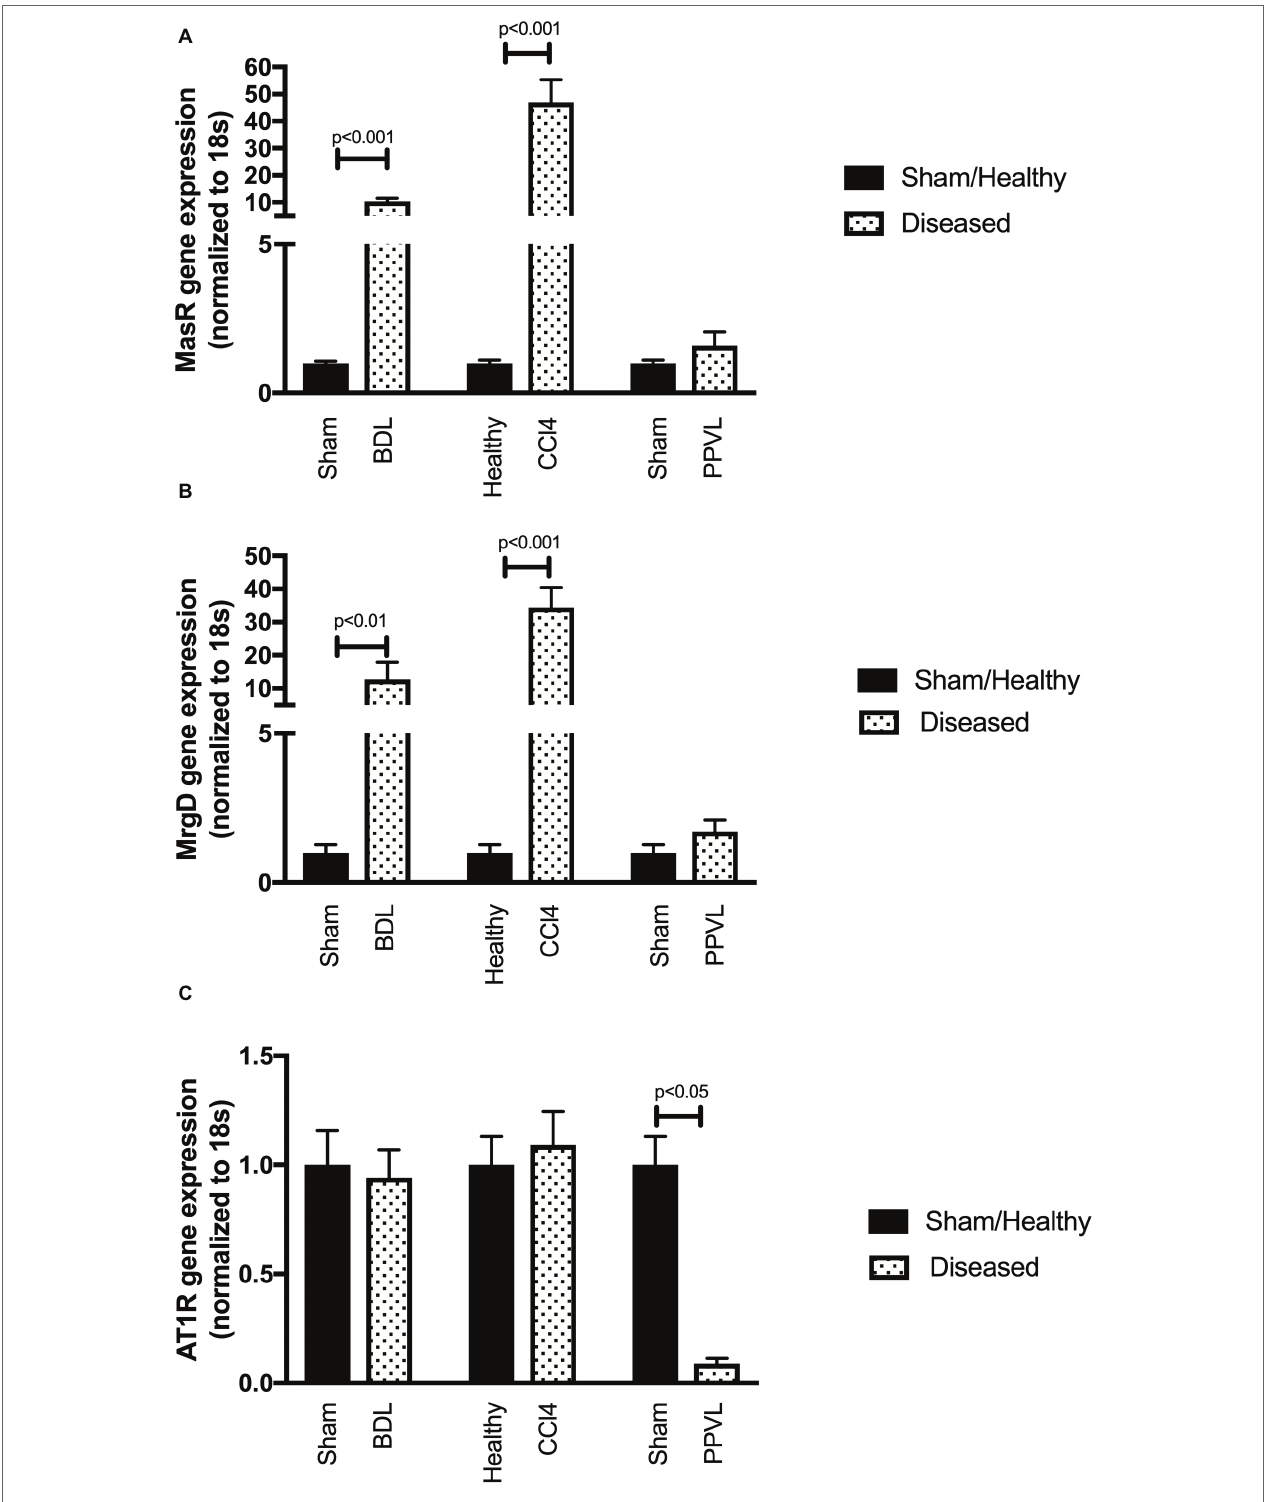
FIGURE 8 | Receptor gene expression of MasR (A) , MrgD (B) , and AT1R (C) analyzed by qPCR in mesenteric vascular bed of the CCl 4 , BDL and PPVL rats compared with sham-operated and healthy control rats. Data have been normalized to endogenous control gene 18S, and healthy control group was given an arbitrary value of 1. Each time point represents the mean ± SEM profile from six to seven rats per treatment